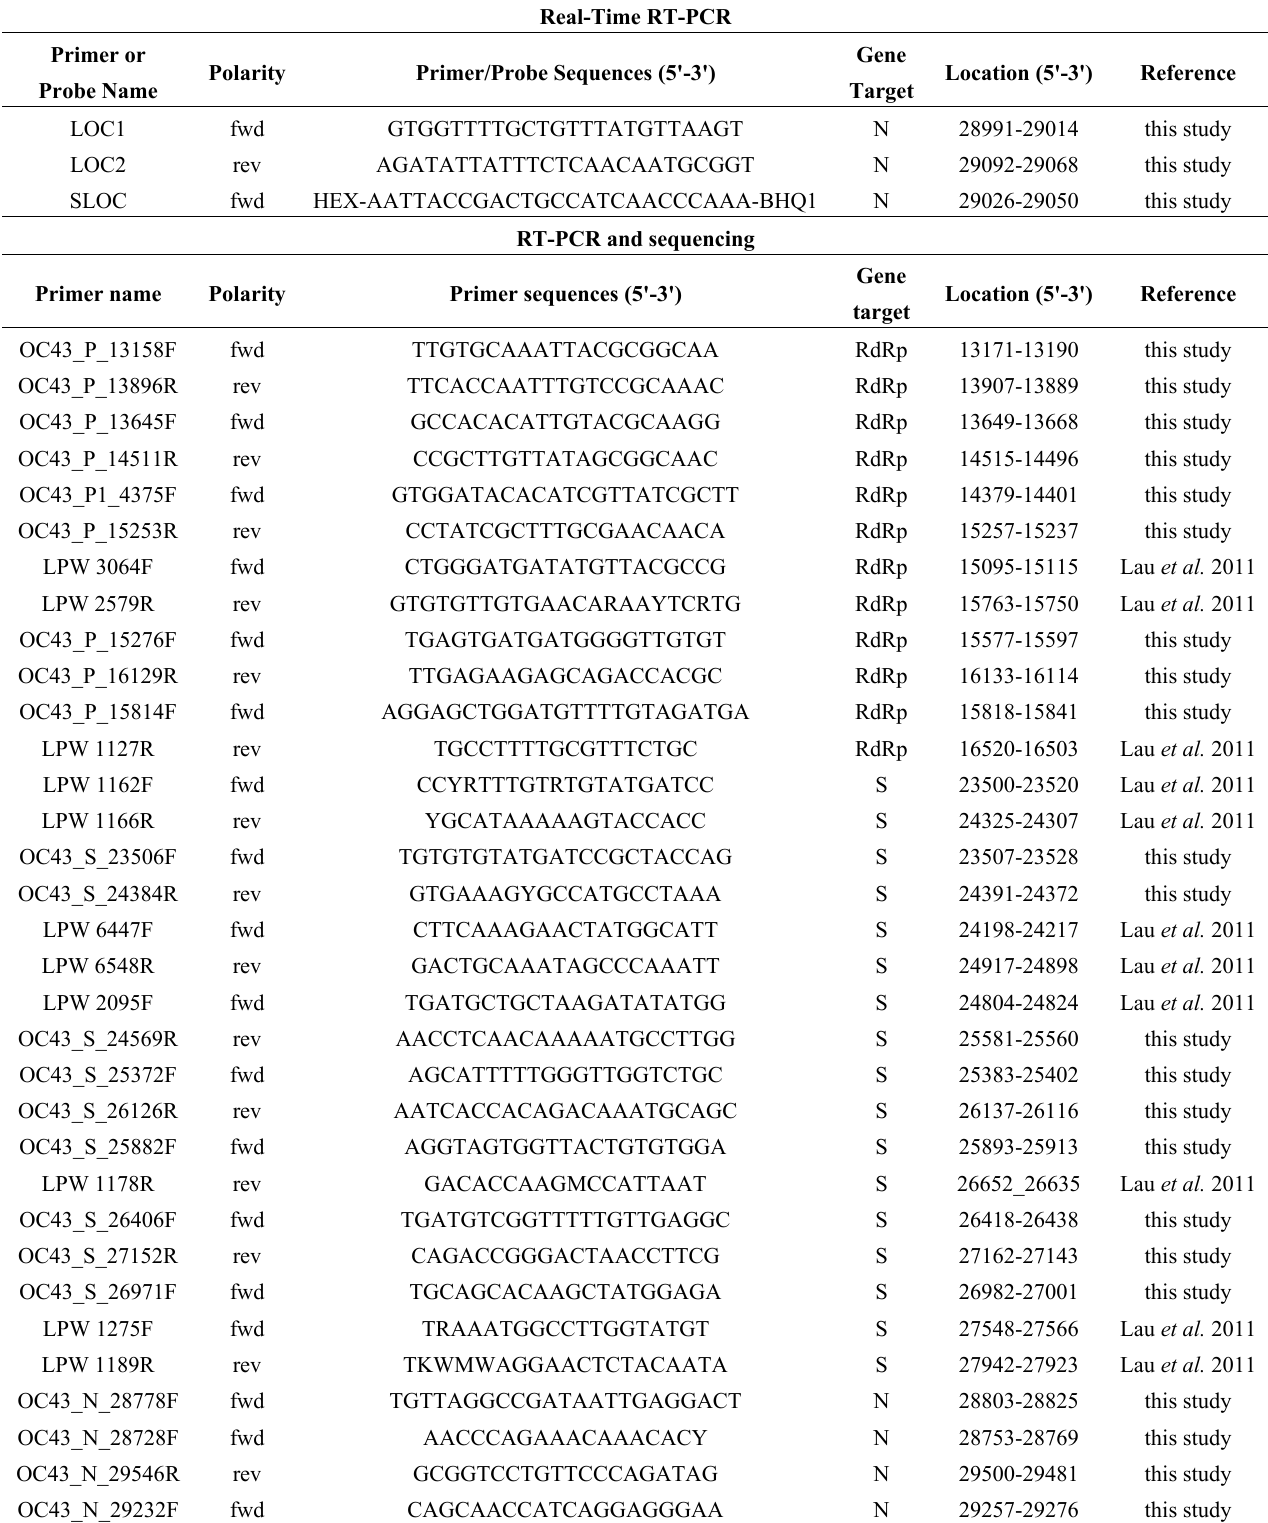
Table 4. Primer and probes used for RT-PCR and full sequencing of nsp12, S, and N genes of 15 HCoV-OC43s, and the prototype strain